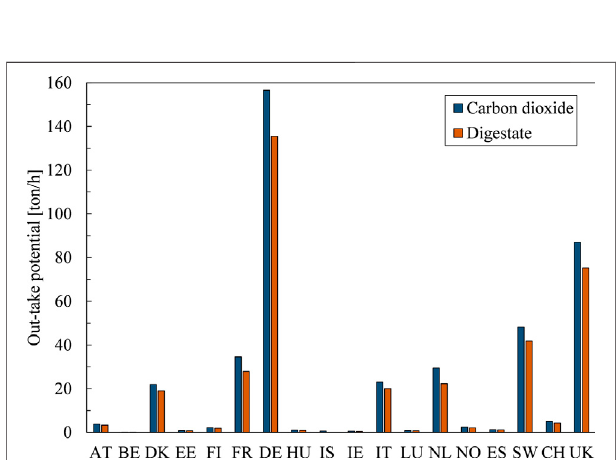
Figure 6 . Among all the countries that currently present installed upgrading units, Germany is the one with the highest availability of useful non-fossil streams.